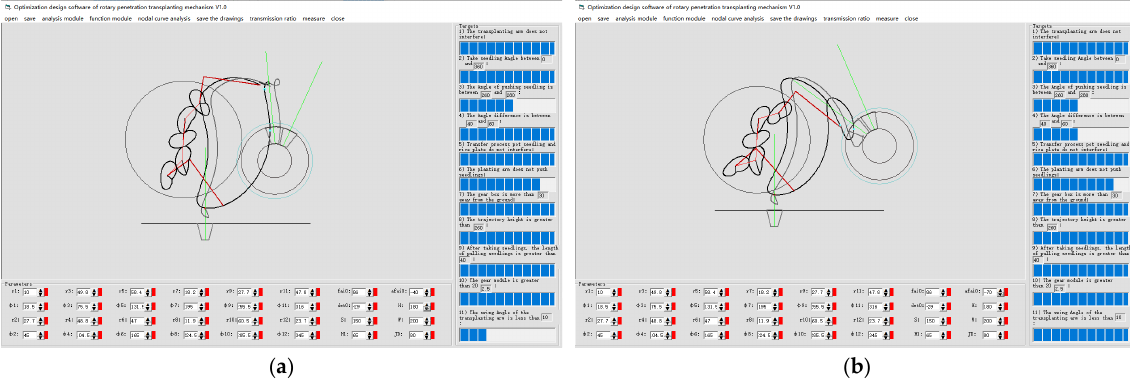
Figure 6. ( a ) transplanting trajectory with decreasing corner; ( b ) transplanting trajectory with increasing corner.